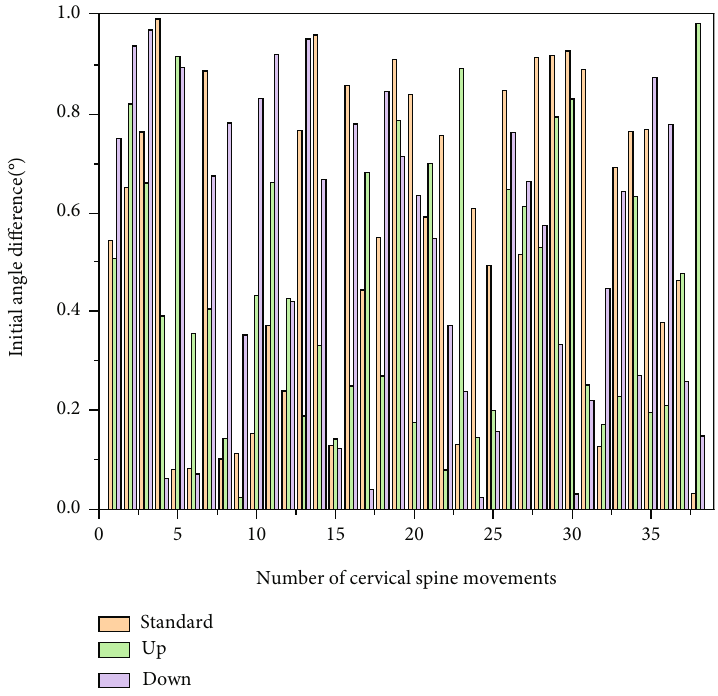
Figure 3: Initial angular di ff erence in cervical spine mobility of the